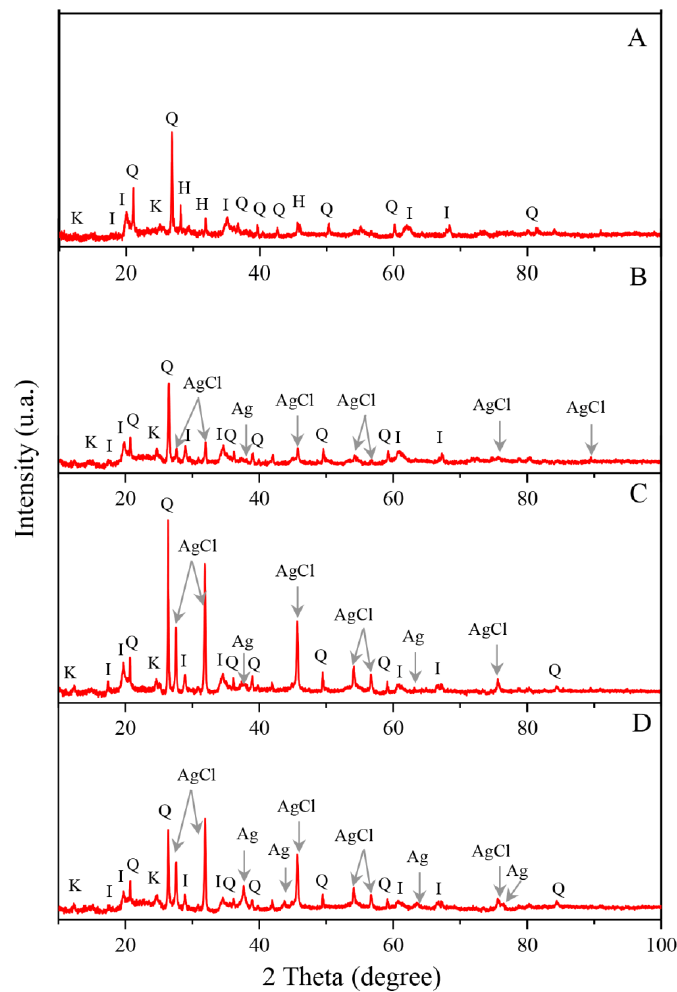
Figure 4. X-ray diffraction patterns of the studied diatomite samples: ( A ) raw diatomite, ( B – D ) diatomite with immobilized silver 0.71, 4.65 and 7.21%, respectively. I—illite, Q—quartz, K—kaolinite, H—halite, AgCl—silver chloride, Ag—metallic silver.